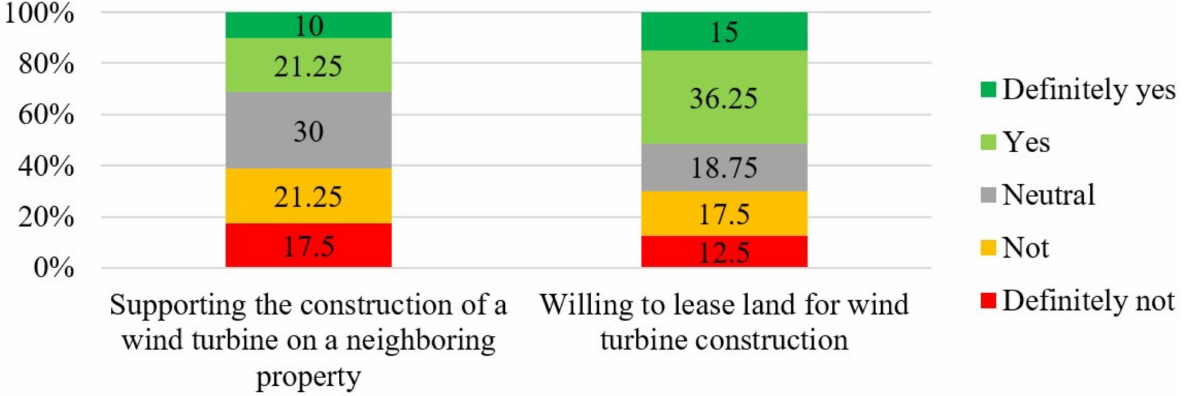
Figure 3. Support for the siting of a wind turbine on an adjacent land plot and the willingness to lease one’s land for the construction of a wind turbine (%). Source: the authors, based on own